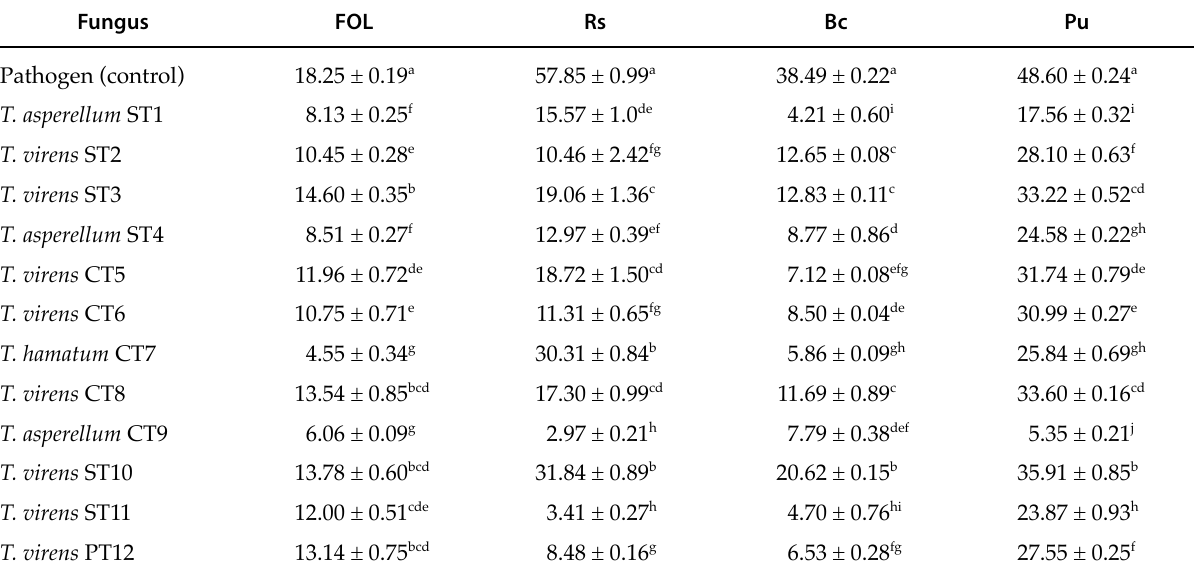
Table 4. Mean colony size (cm 2 ) of Fusarium oxysporum f. sp. lycopersici (FOL), Rhizoctonia solani (Rs) Botrytis cinerea (Bc) and Pythium ultimum (Pu) after 5 d growing alone (control) or in dual culture with the 12 different Trichoderma spp. strains isolated in this work.